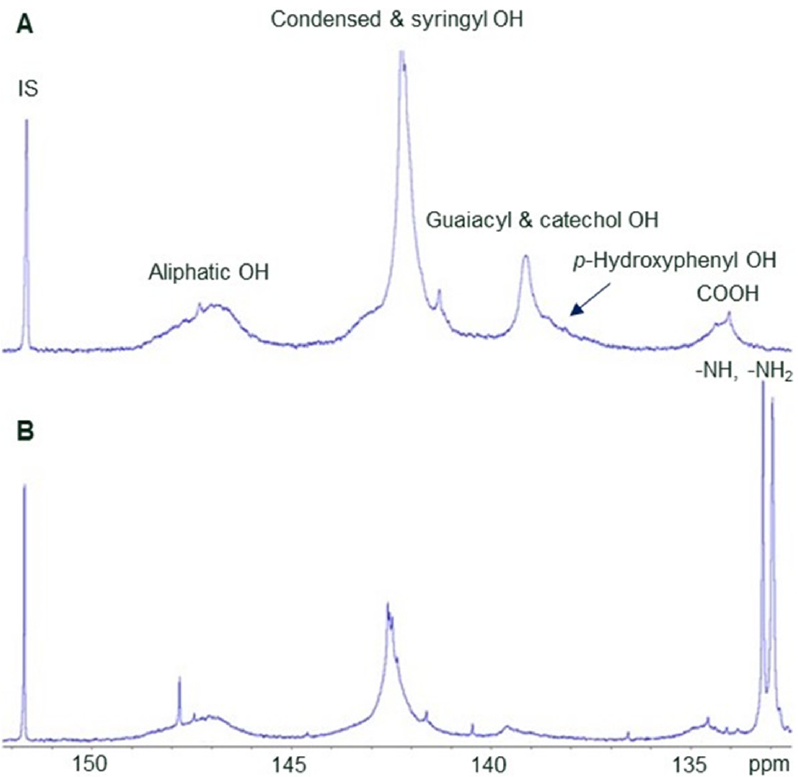
Figure 2. 31 P NMR spectra of HW kraft lignin before ( A ) and after ( B ) reaction with urea and formaldehyde. IS = internal standard.